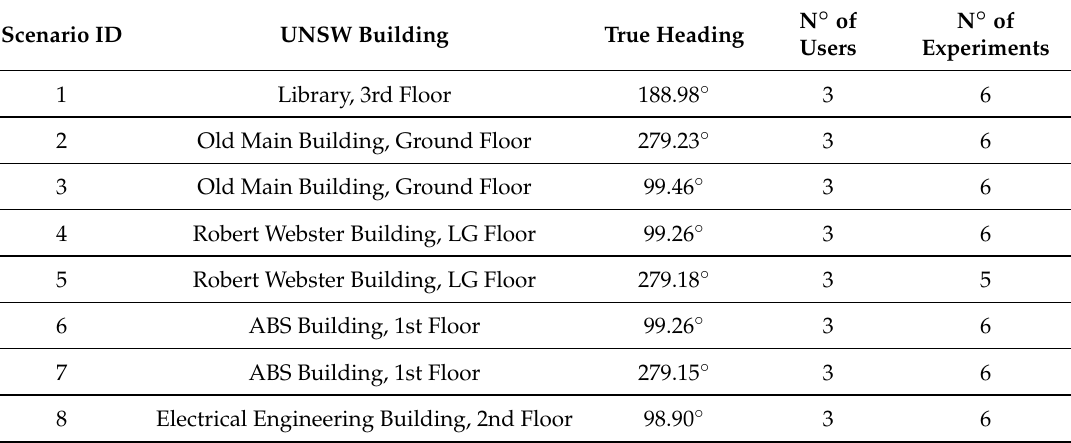
Table 2. Large-Scale Scenario